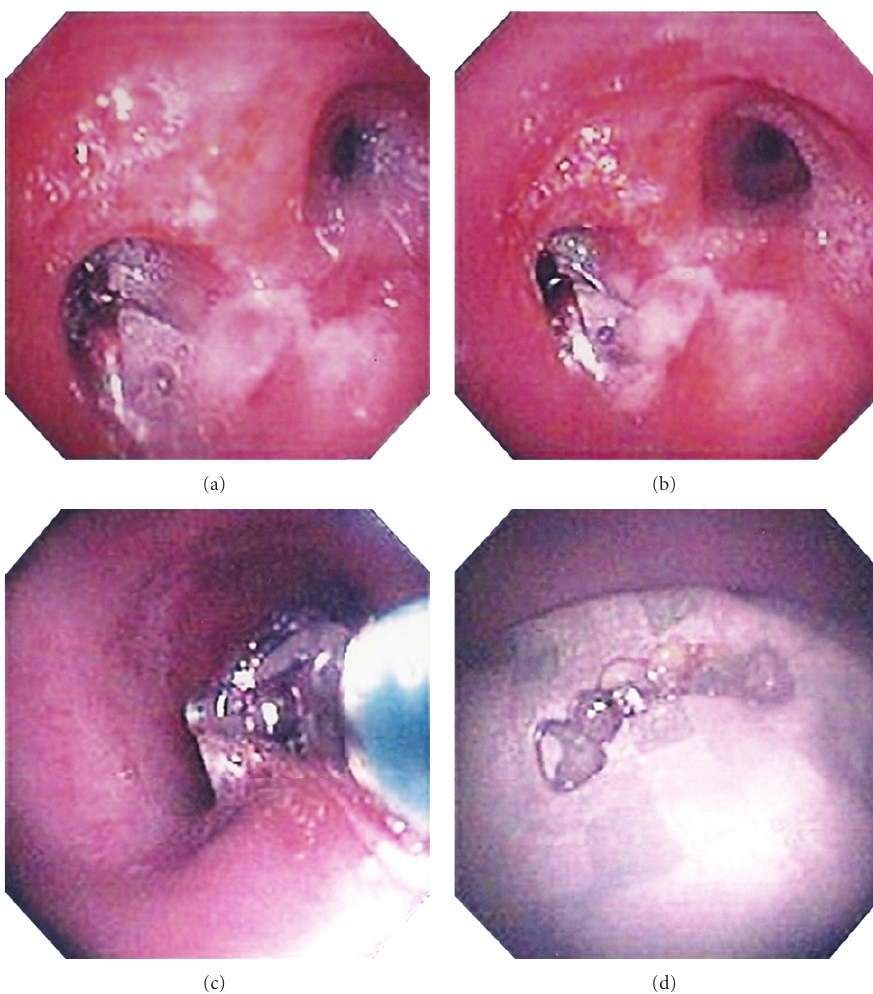
Figure 2: Bronchoscopic images obtained during extraction of the dental prosthesis. (a) and (b) depict the prosthesis within the left main stem bronchus. (c) demonstrates the endobronchial forceps grasping the prosthesis during extraction as it is passing through the mid trachea. (d) shows the prosthesis on a bedside tray after